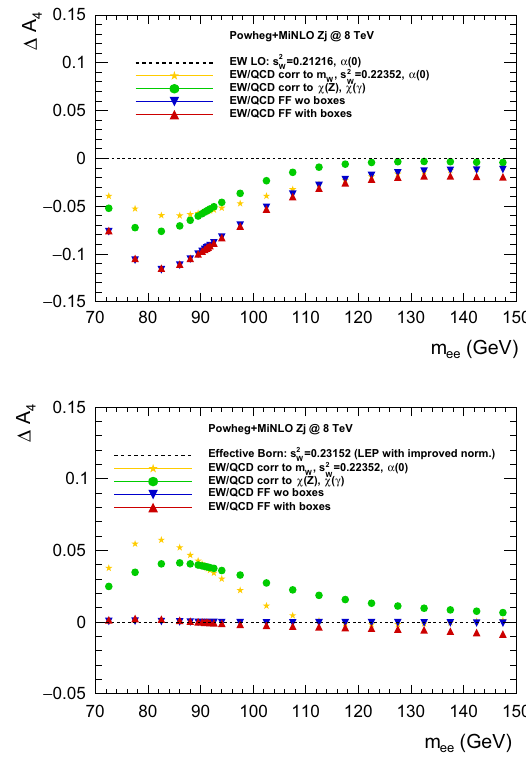
Fig. 7 Top-left:the A 4 asfunctionof m ee .Overlayedaregeneratedand corrections are shown in consecutive plots, where as a reference A ref EW corrected A 4 predictions. These results are barely distinguishable. (black dashed line) respectively (i) EW LO α( 0 ) scheme (top-right), (ii) effective Born ( LEP ) (bottom-left) and (iii) effective Born ( LEP with due to gradually introduced EW The differences (cid:8) A 4 = A 4 − A ref 4 improved norm. ) (bottom-right) was used